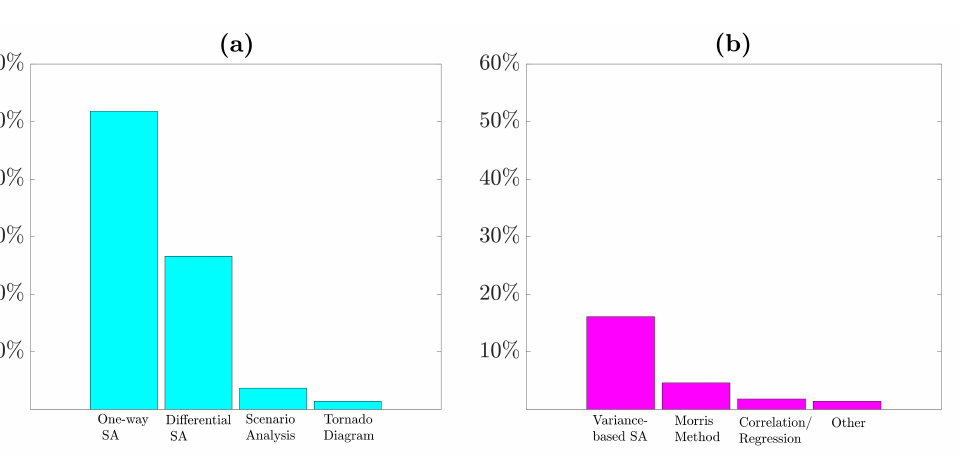
Figure 6. Percentages of local ( a ) and global ( b ) SA methods over the total number of papers featuring